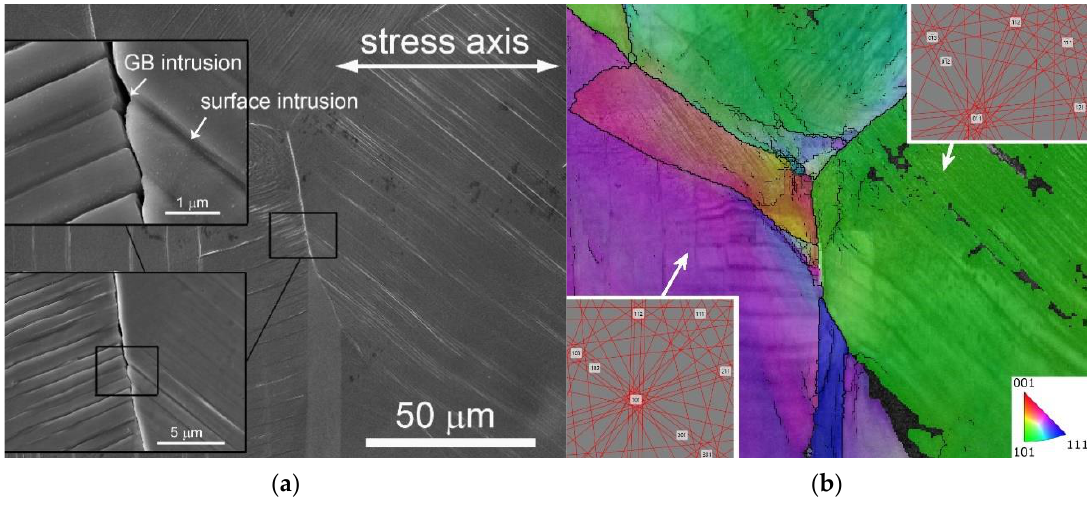
Figure 19. Surface of polycrystalline copper cycled with ε H = 4 × 10 −3 for 560 cycles (10% N f ); ( a ) the details show extrusions and intrusions (white arrows) both on the surface and at the grain boundary, ( b ) the EBSD image shows the orientation of neighbor grains.